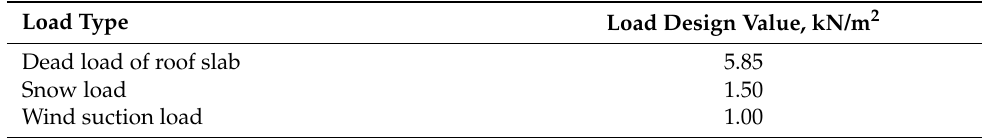
Table 4. Design values of loads applied to the wall in a persistent design